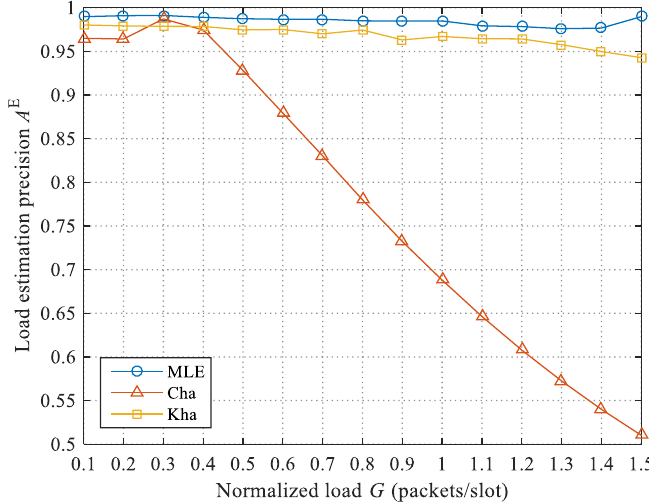
Figure 3. Comparison of load estimation precisions of the three load estimation algorithms.